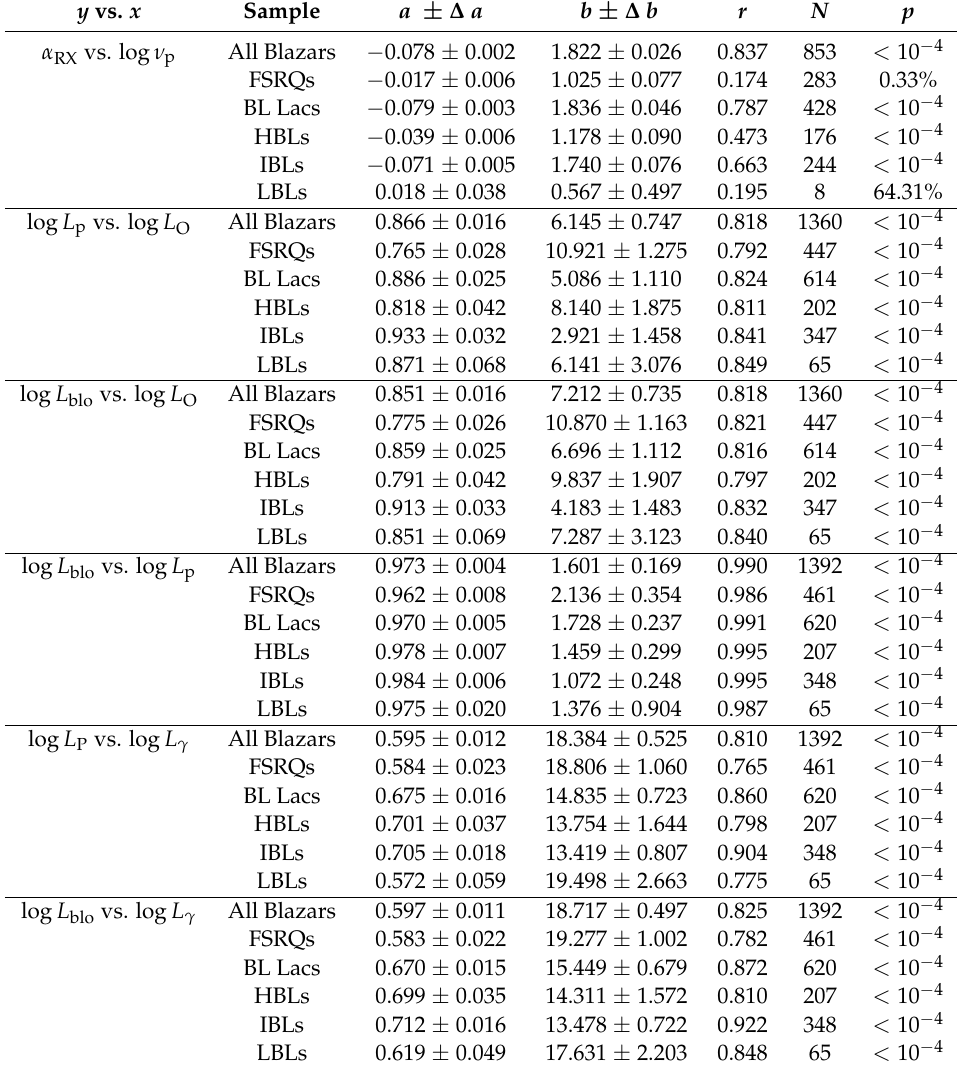
Table 1. Some correlation results for Fermi